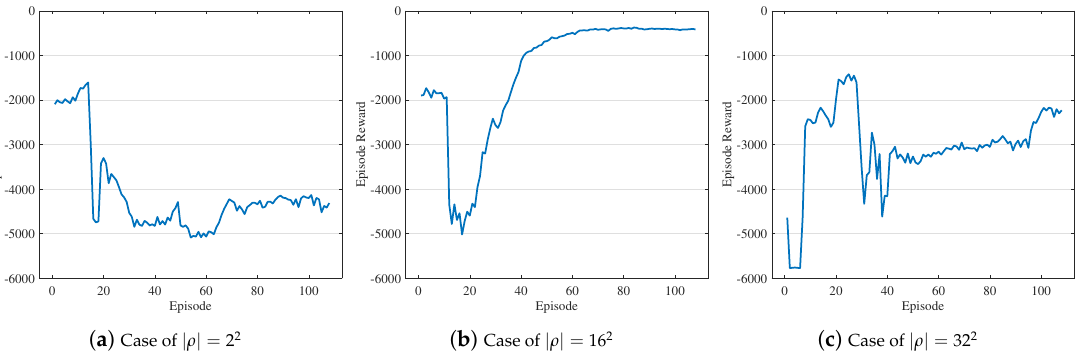
Figure 20. Comparison of stable and unstable cases: ( a – c ) the learning curves for the cases of | ρ | = 2 2 , 16 2 , and 32 2 , respectively, in Figure 19b, illustrating effects by | ρ | value settings, the dimension of abstract